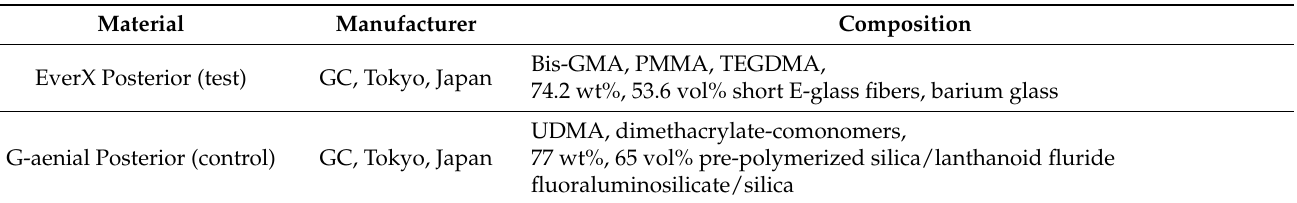
Table 1. Chemical composition, weight percentage of the organic matrix, and volume percentage of fibers and fillers of the tested